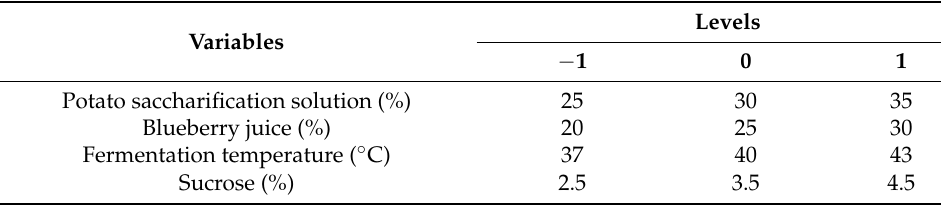
Table 2. BBD design factors and horizontal